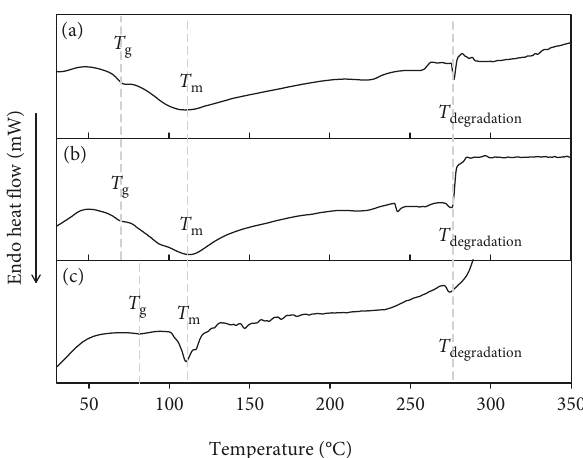
Figure 3: DSC curves of (a) gelatin powder, (b) GES-25, and (c) GES-25/EMImBF